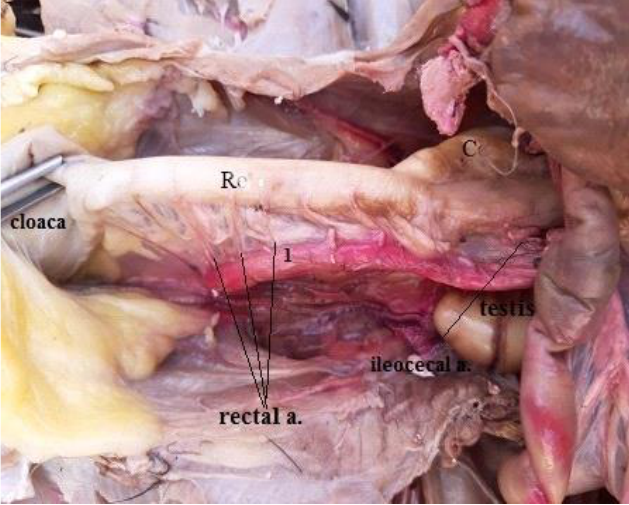
Figure 9 . Photograph illustrates caudal mesenteric artery of adult turkey: 1: caudal mesenteric artery, C: ceacum , R: